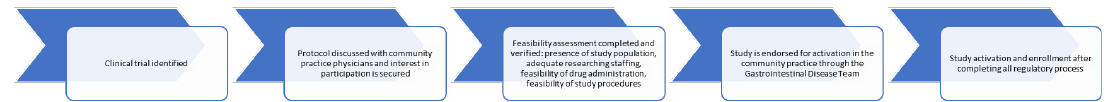
Figure 1. Process for clinical trial activation in a City of Hope Community Practice.